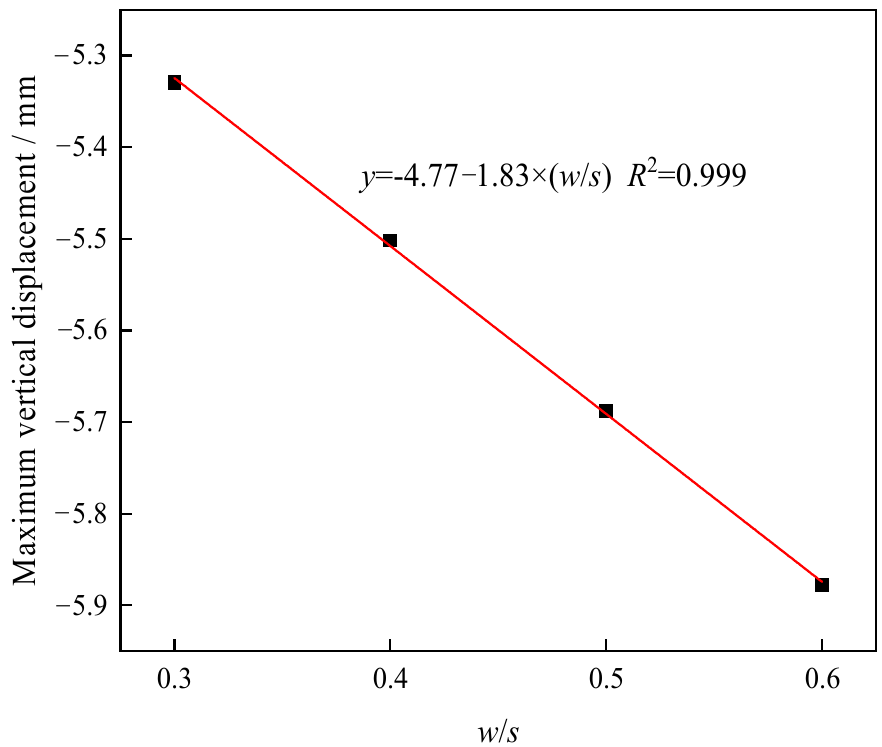
Figure 23. Vertical displacement curve of the tunnel vault.